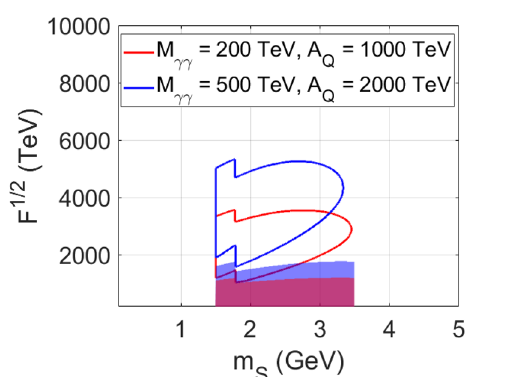
Figure 12 . FASER-II sensitivity to the model parameter space, where sgoldstino is produced in beauty meson decays and decay into a photon pair within the detector. M 3 = 3 TeV. Shaded areas correspond to restrictions from table 1. In the regions where